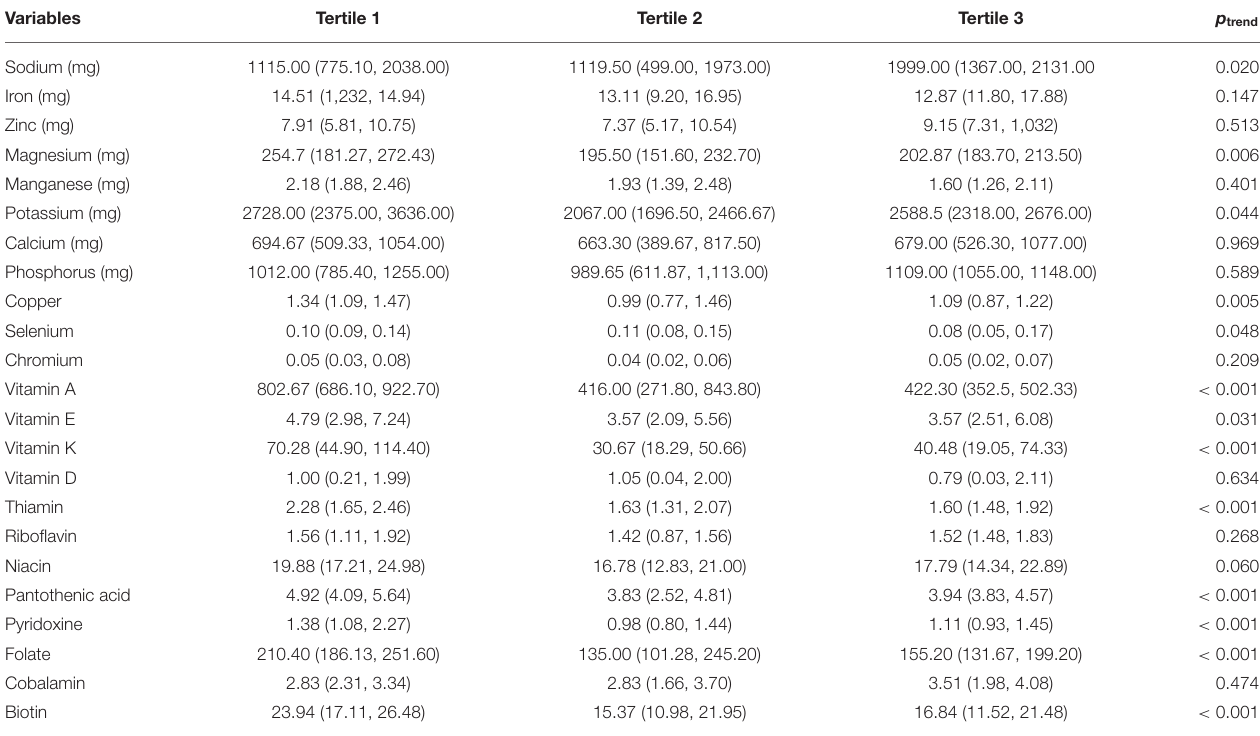
TABLE 3 | Micronutrient intake of the participants according to the tertiles of dietary inflammatory index. Variables Tertile 1 Tertile 2 Tertile 3 p trend